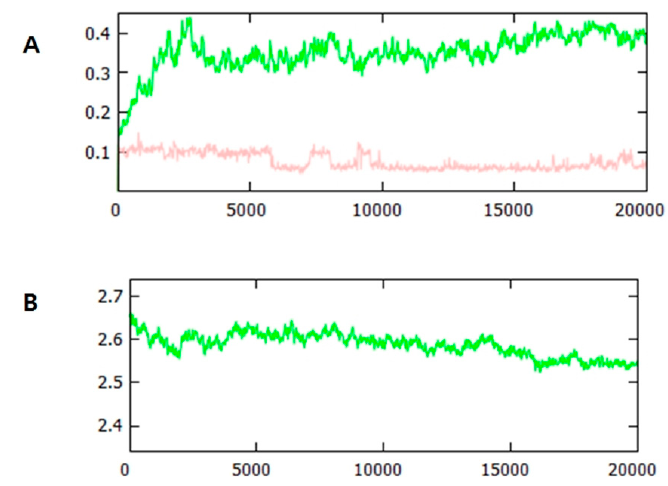
Figure 10. CBH binding mediated changes observed in the structure of HSA during the 20 ns time scale of molecular dynamics simulation. ( A ) RMSD plot of HSA in complex with CBH. HSA in indicated by green line while CBH is indicated by light pink. ( B ) Rg of C α atoms of HSA in complex with CBH.